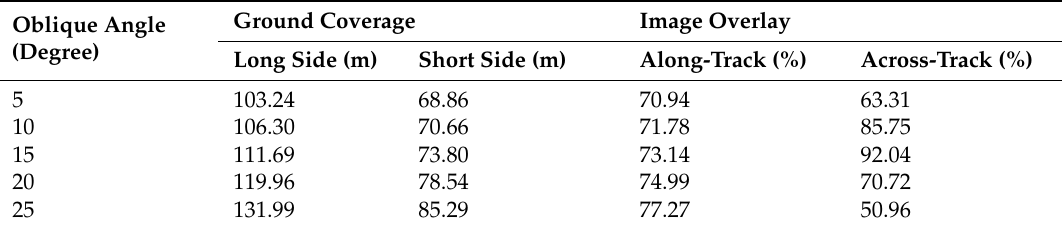
Table 2. Ground coverage and degree of overlap of images acquired by the integrated photogrammetric system under flight height of 100